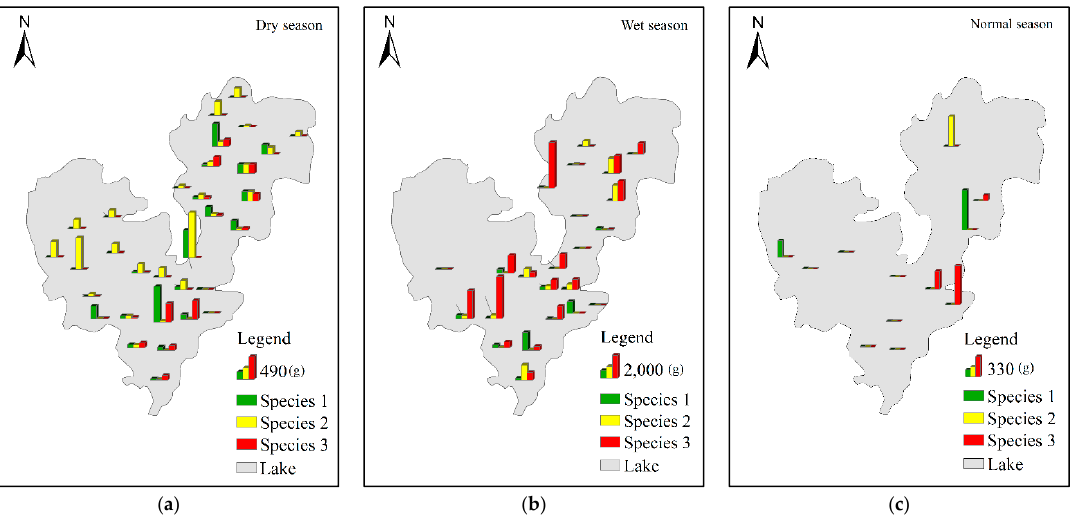
Figure 5. The distribution of submerged aquatic plants biomass for different species in three seasons. ( a ): dry season; ( b ): wet season; ( c ): normal season. Species 1: Myriophyllum verticillatum ; Species 2: Stuckenia pectinata (L.) Börner sago pondweed ; and Species 3: Ceratophyllum demersum L. Table 2. Factor loadings of eight variables based on PCA in three seasons.